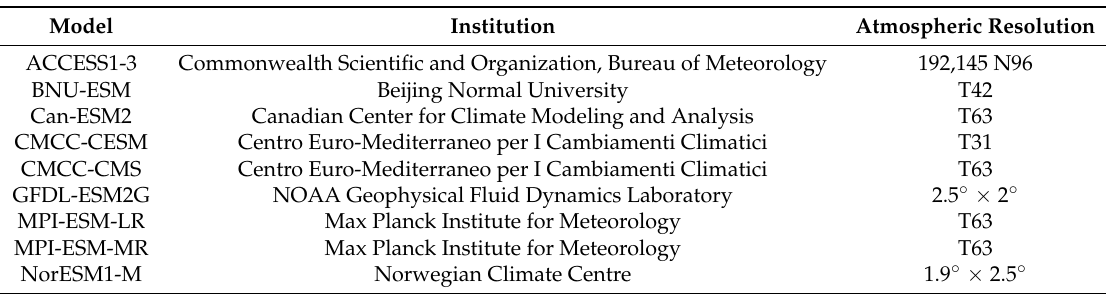
Table 1. Details of CMIP5 models used in this